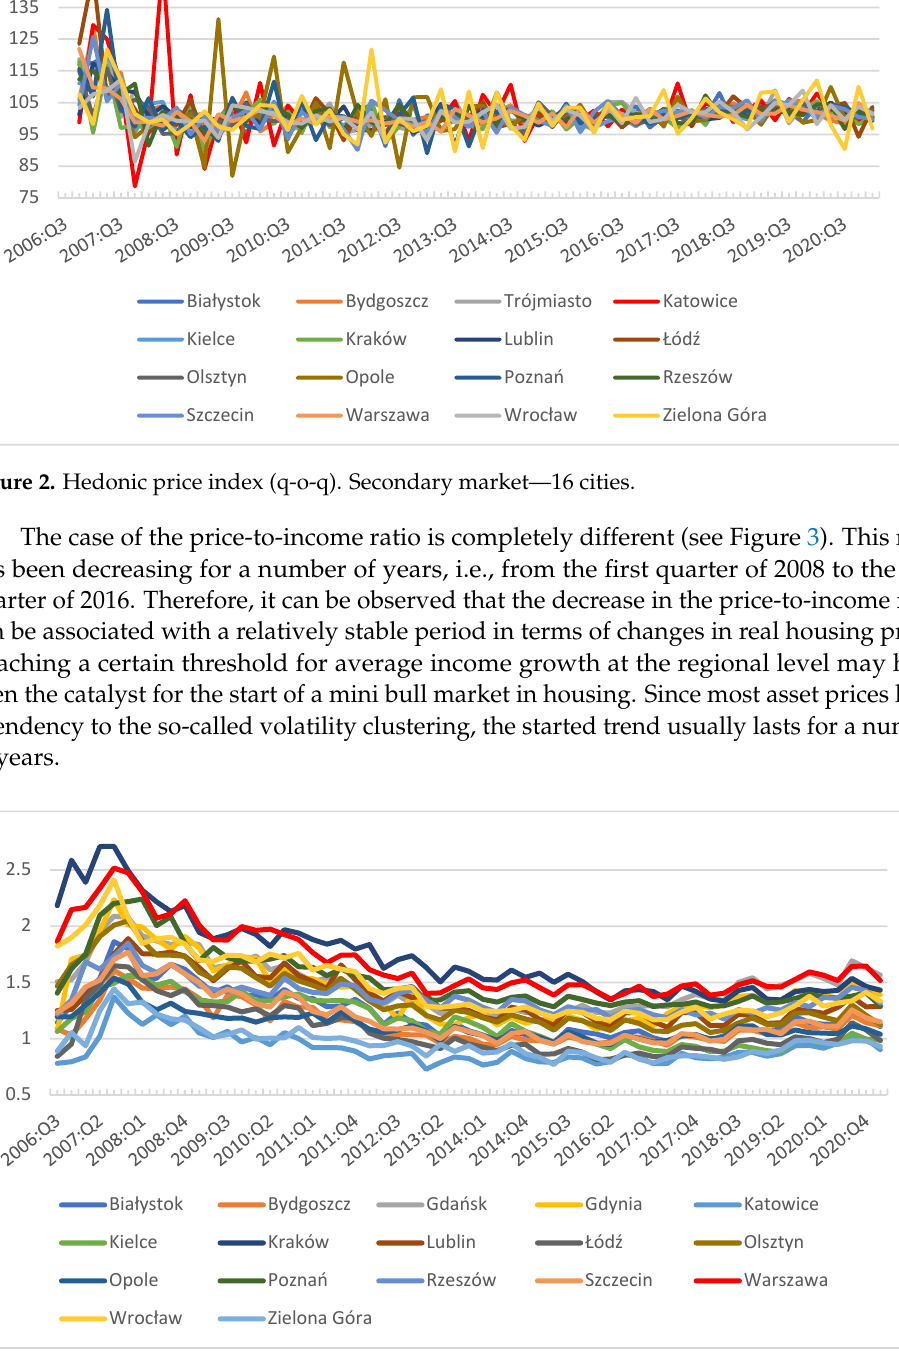
Figure 4. Price-to-income ratio around the World (2020:Q4 or latest available index, 2015 = 100). Source: Organisation for Economic Co-operation and Development. 3.2. Different Approaches for Detecting Explosive Dynamics There are many research methods in the literature for identifying price bubbles; some of them are simple statistical analyses, but there are also a whole range of complex econometric models, including nonparametric models (European Central Bank 2010;